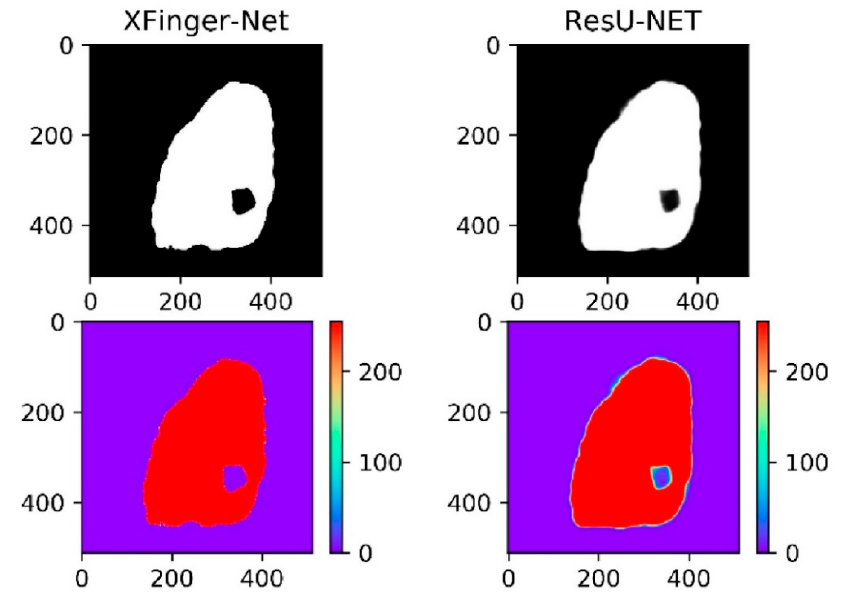
Figure 14. Thermal map of the segmentation result of XFinger-Net and ResU-Net.